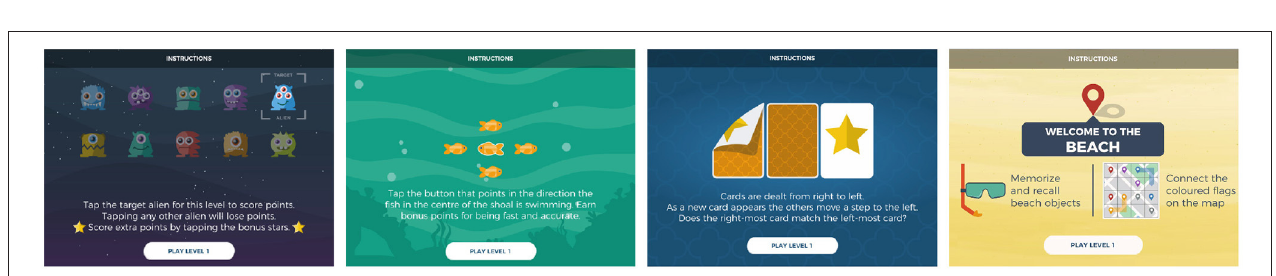
FIGURE 3 | Images of 2-stimulus visual oddball, flanker, n-back, and delayed match-to-sample gamified